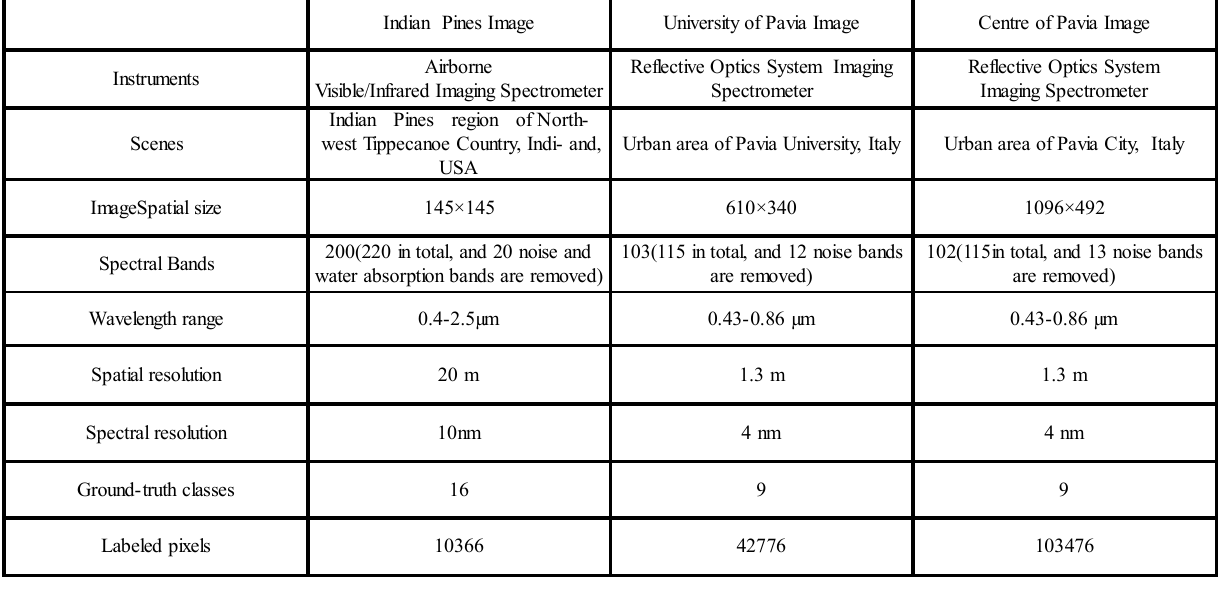
TABLE 1.DESCRIPTION OF DATA